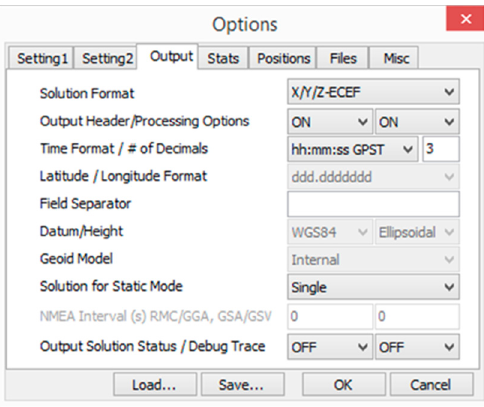
Figure 4. Output options interface with the RTKPOST module.